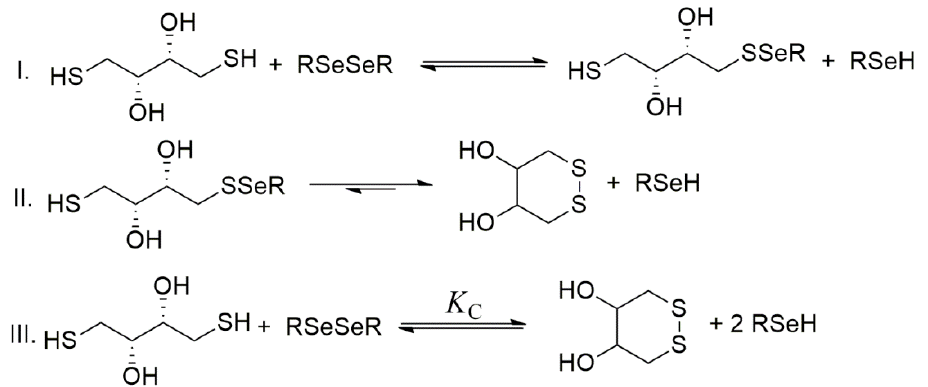
Figure 5. The two-step redox equilibrium between a diselenide compound and DTT 2 − (reactions I and II), followed by their unified net reaction (III). Identical reaction schemes are applicable for disulfide analogs. The short arrow in reaction II indicates the low probability of the formation of the sulfur–selenium bridge.